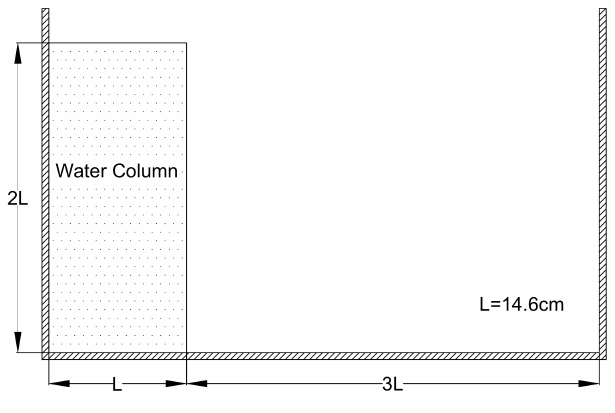
Figure 5. Geometry of the dam-break